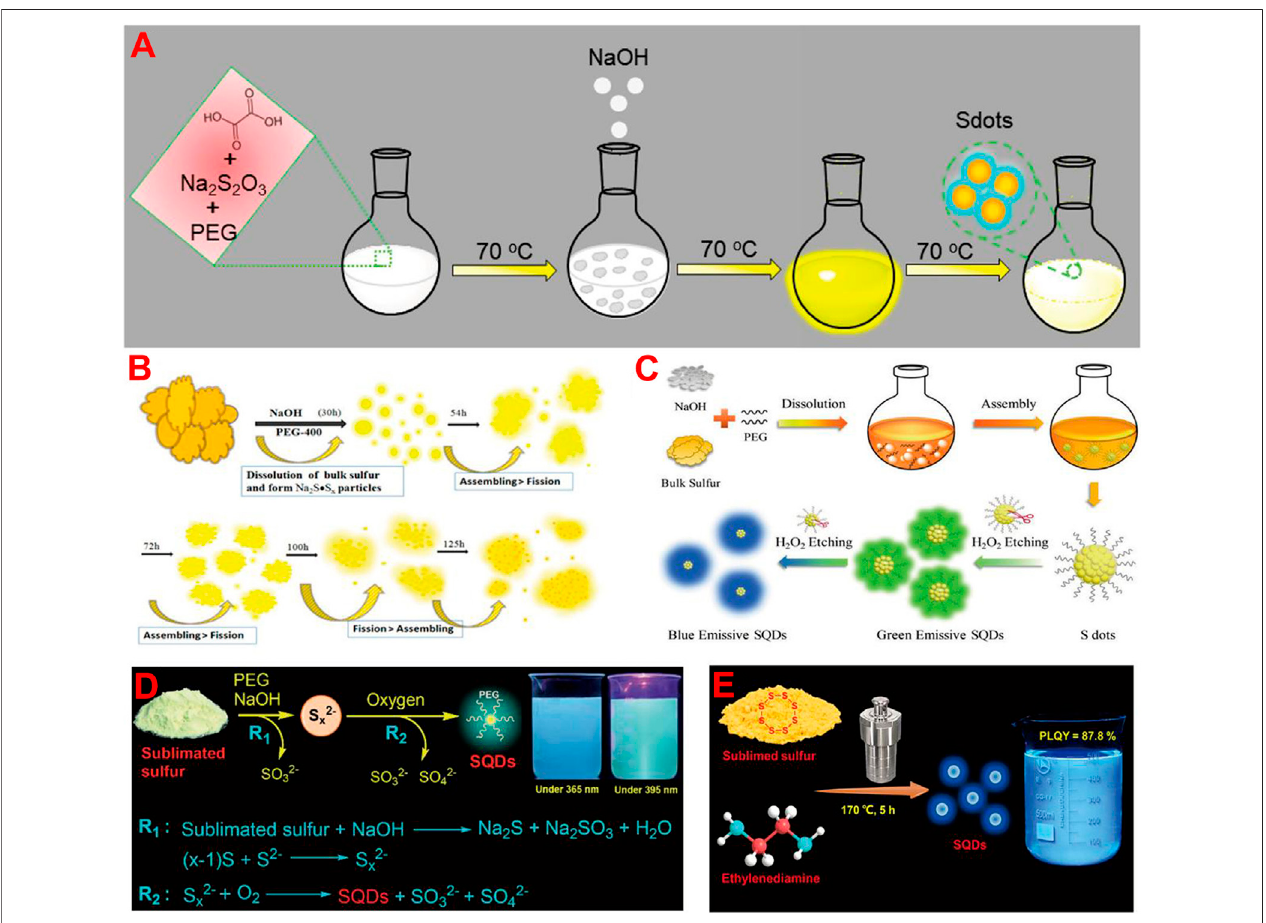
FIGURE1| Schematic illustration ofthesynthesisof fl uorescentSQDs byusing bottom-up (A) and top-down (B – E) strategies, respectively. (A) Reproduced,with permission, from Arshad and Sk, 2020. Copyright 2020, American Chemical Society. (B) Reproduced, with permission, from Shen et al. (2018). Copyright 2018, American Chemical Society. (C) Reproduced, with permission, from Wang H. et al. (2019). Copyright 2019, Wiley. (D) Reproduced, with permission, from Song et al. (2020). Copyright 2020, Royal Society of Chemistry. (E) Reproduced, with permission, from Gao et al. (2022). Copyright 2022, American Chemical Society.